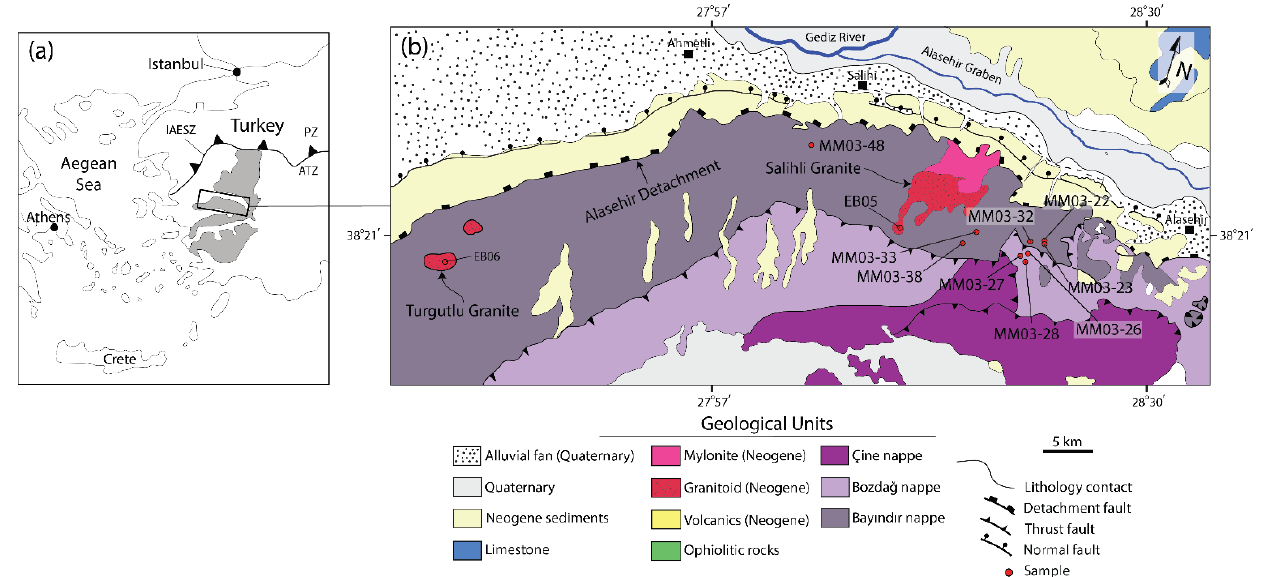
Figure 1. Geological map of the Menderes Massif, western Turkey, modified from [23]. ( a ) Regional map of the Aegean Sea and western Anatolia. This shows the location of the Menderes Massif and its position in relation to the Izmir—Ankara—Erizincan Suture Zone (IAESZ). ( b ) Simplified geological map of the Central Menderes Massif. The locations of samples referenced in this study are labeled.